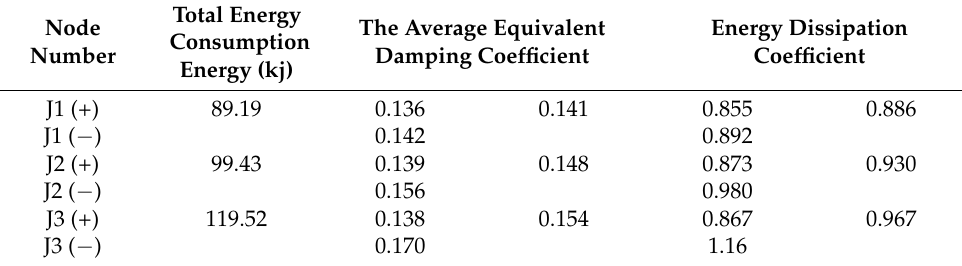
Table 11. Energy consumption capacity